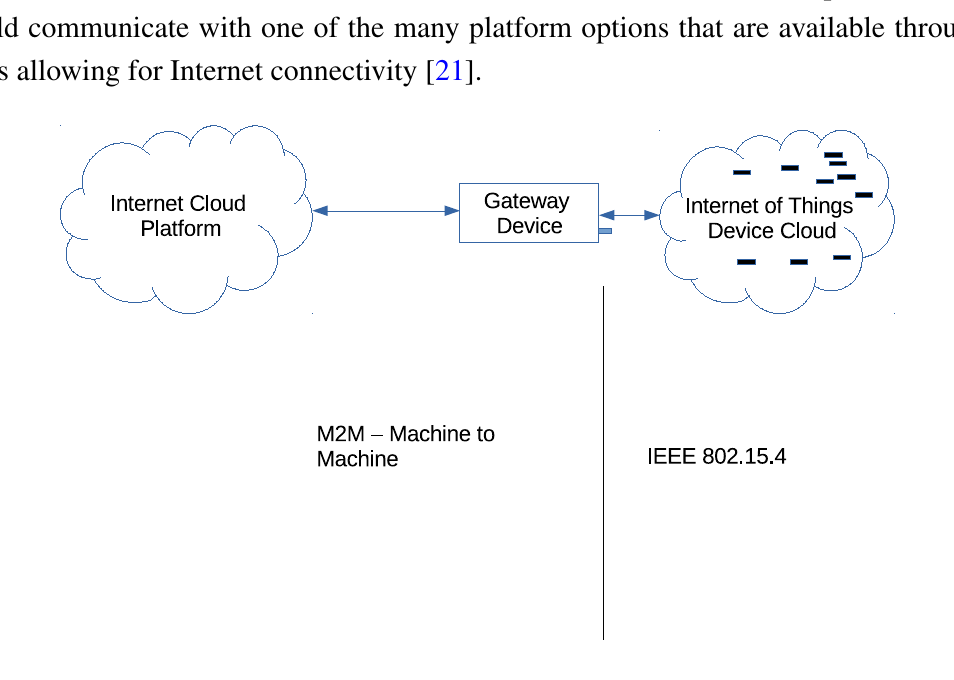
Figure 1. Internet of Things generic network